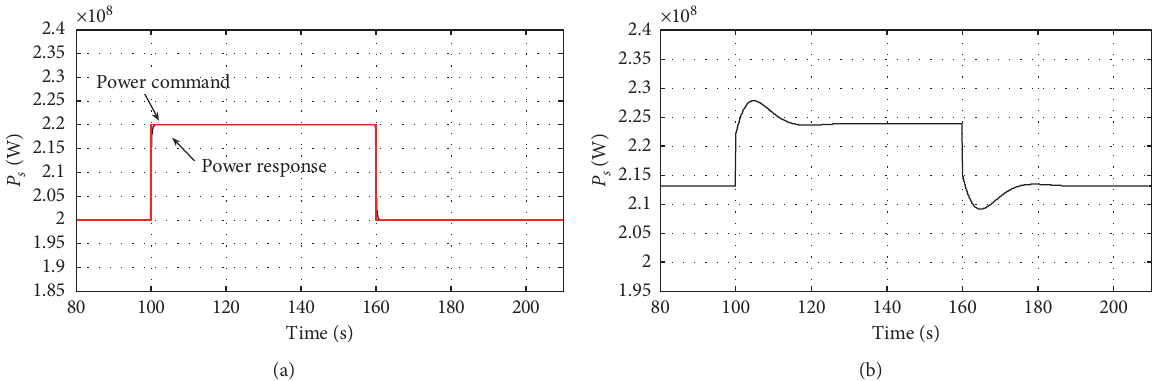
Figure 38: Comparison diagram of the stator-side active power. (a) Power priority control strategy. (b) Speed priority control